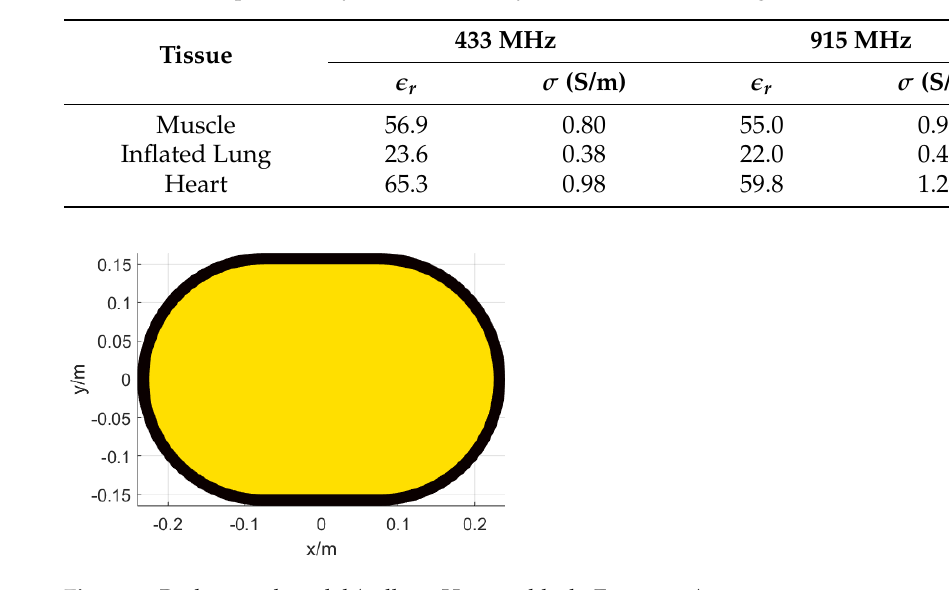
Table 1. Relative permittivity and conductivity of muscle, inflated lung, and heart.